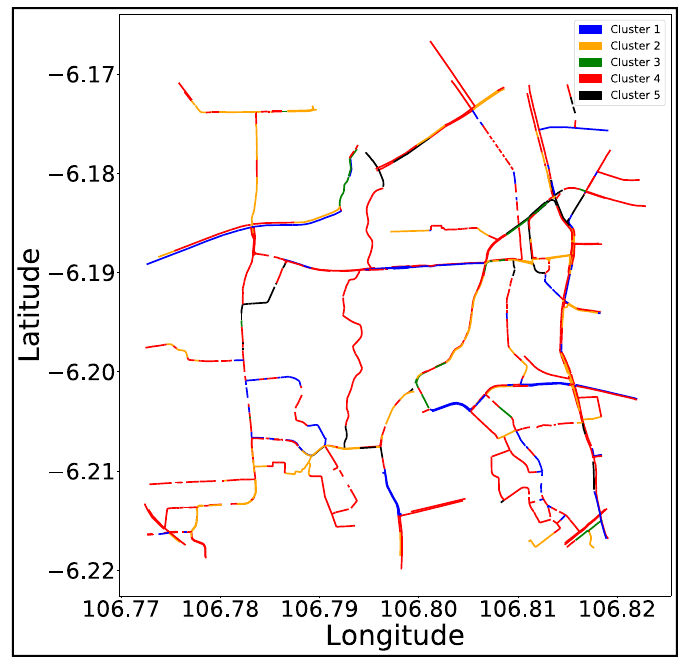
Figure 7. The road representation of the clustering results of the experimented area.